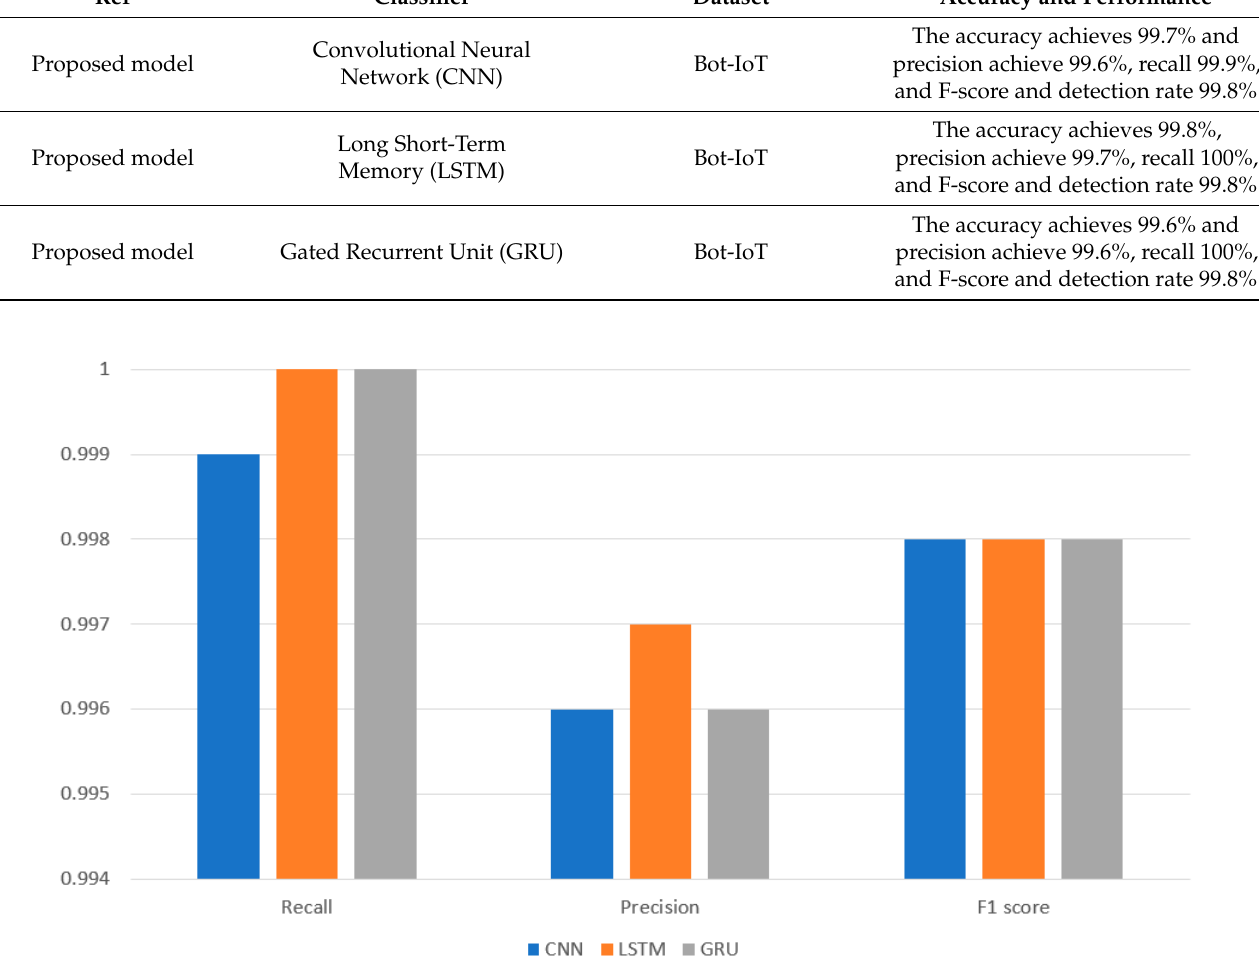
Figure 3. Experiment results for precision, recall and F1 score.